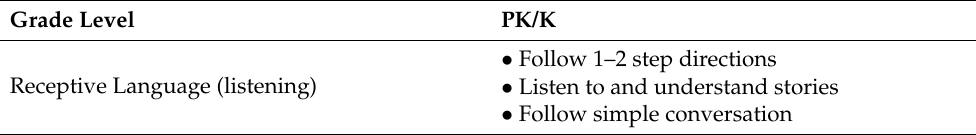
Table 6. Language Checklist.